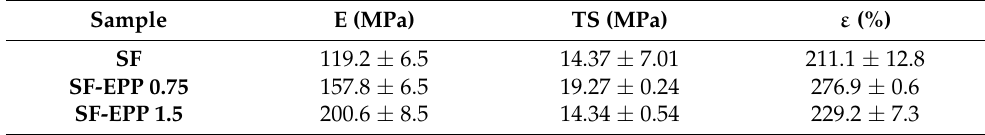
Table 2. Mechanical parameters determined at T = 37 ◦ C and 80%